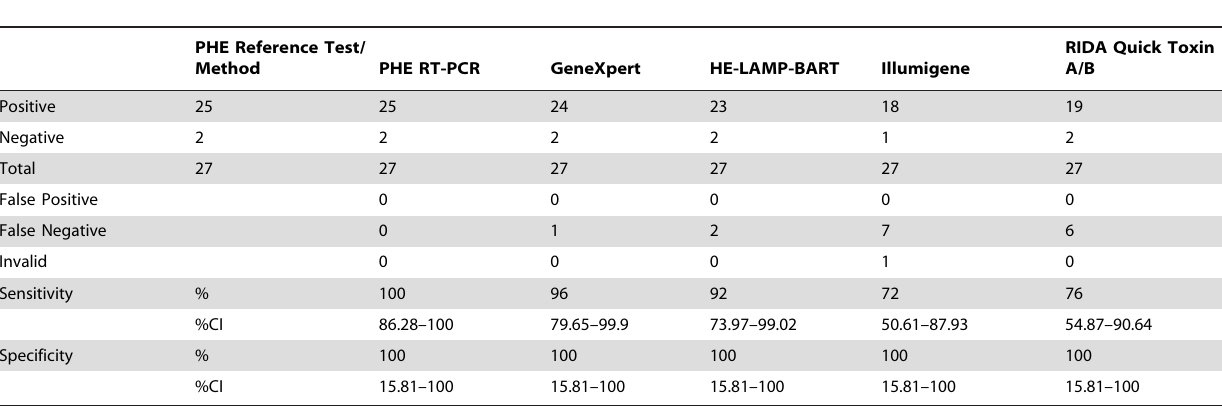
Table 6. Comparison of a subset of samples from the Illumigene-HE-LAMP-BART study with GeneXpert and RIDAQuick against the reference